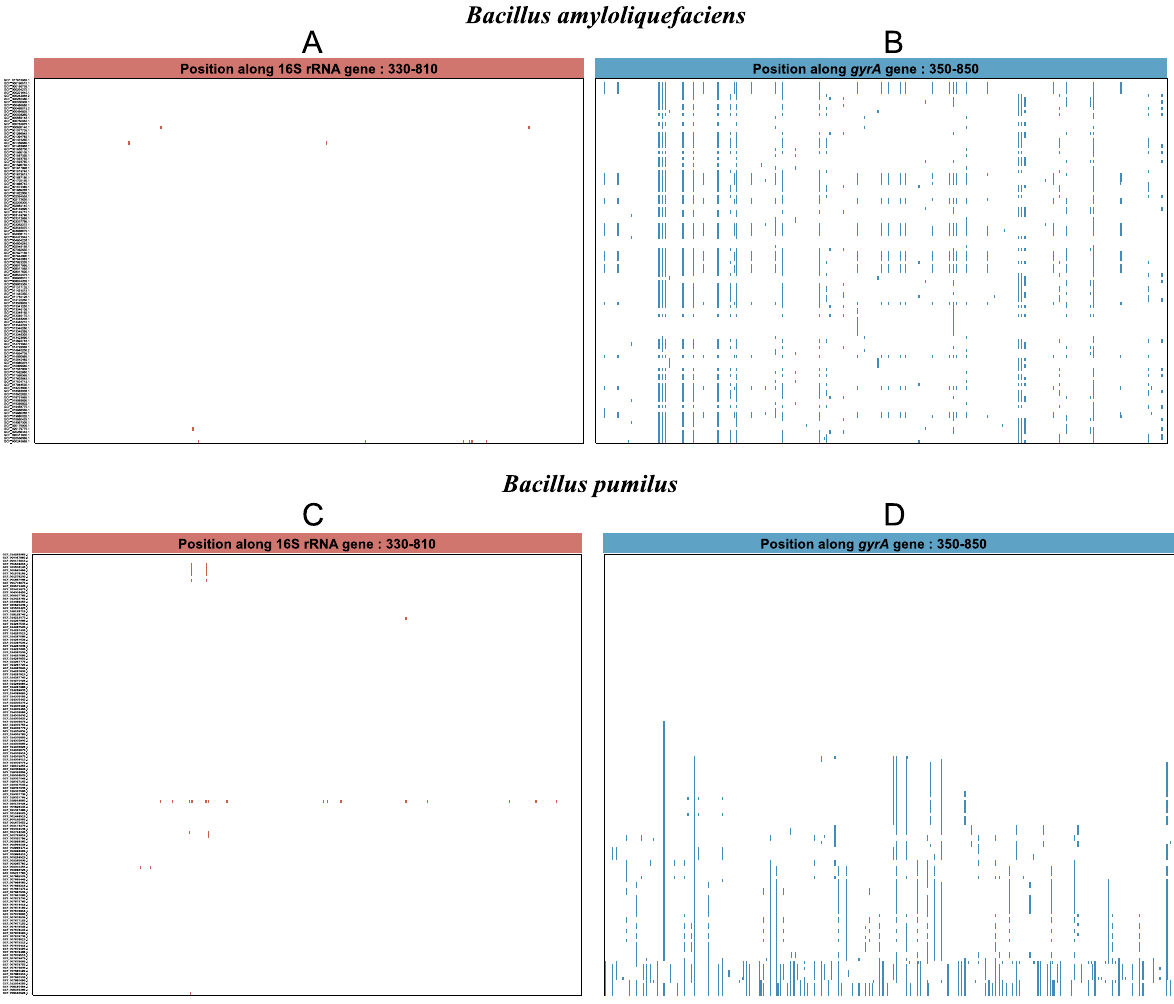
Fig. 4 Alignment of the 16S rRNA and gyrA sequences of B. amyloliquefaciens (116 genomes) and B. pumilus (140 genomes). Sequences were aligned using L‑INS‑I method of MAFFT (v7.487). The analysis involved positions along 16S rRNA from 330–810 and along gyrA from 350–850. On the left side of the graph GCF reference numbers of genomes were displayed, with reference sequence GCF_017815555.1 displayed at the top for B. amyloliquefaciens and GCF_014269965.1 for B. pumilus . The display of base site variation was drawn using MEGA (v.5.05). The colored line (red or blue) indicates a variation of specific base sites as compared to the reference